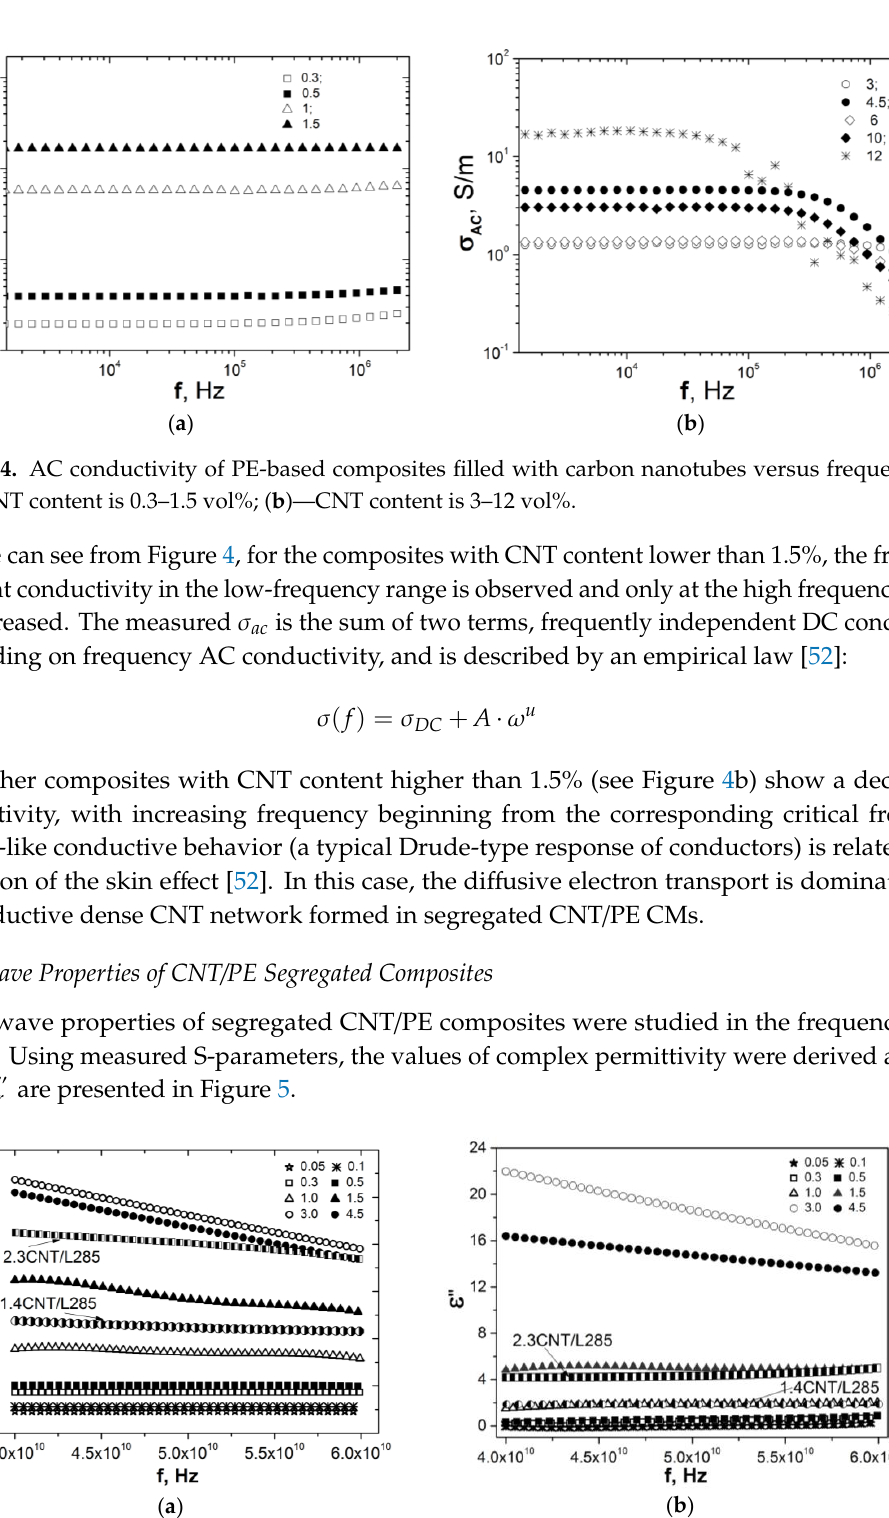
Figure 5. The real 𝜀 𝑟′ (а) and imaginary 𝜀 𝑟′′ (b) parts of dielectric permittivity for CNT-based segregated and random composites in the frequency range 40–60 GHz.